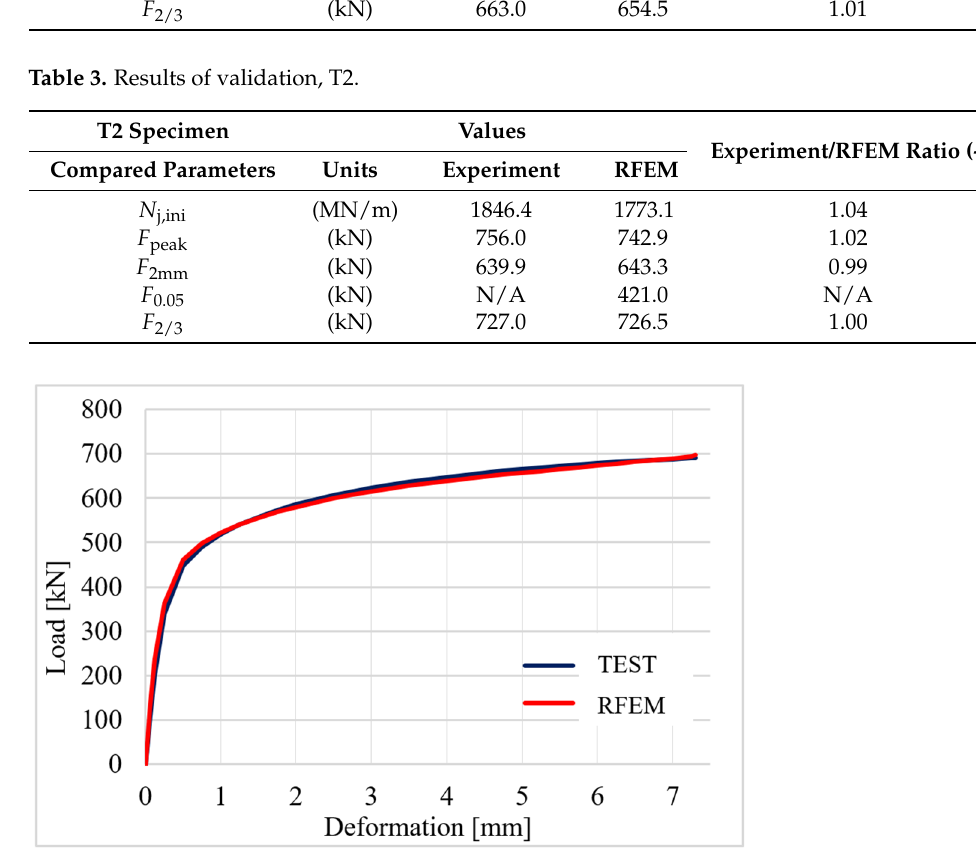
Figure 10. Load vs. deflection curve, RFEM and experimental curves of specimen T1.